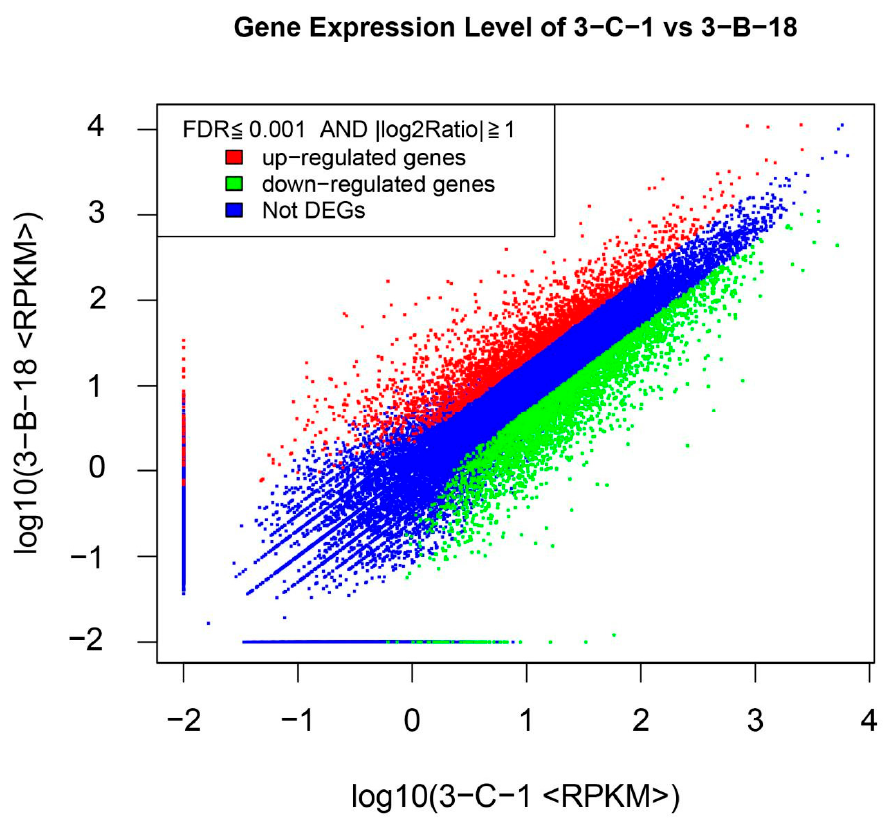
Figure 2. Number of significantly differentially expressed genes in “Nanlin895” roots exposed to boron deficiency.